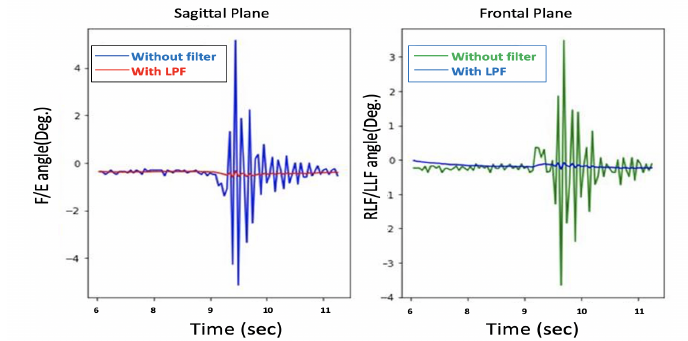
Figure 6. Before and after low pass filter with only